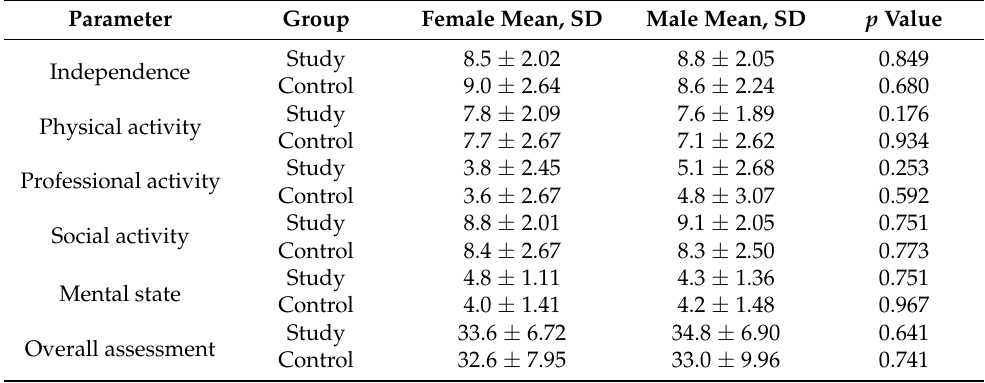
Table A2. Subgroup and overall QoL scores in females and males with brain tumors with and without